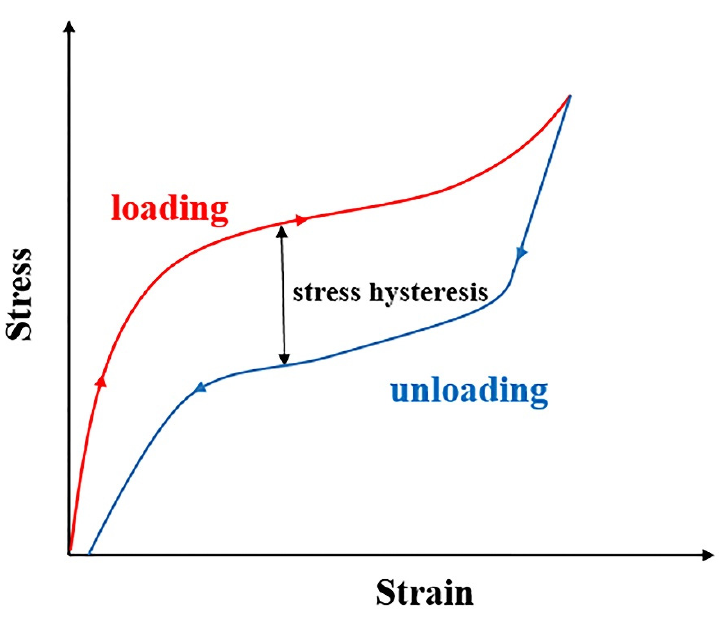
Figure 4. Typical superelastic stress–strain curve.